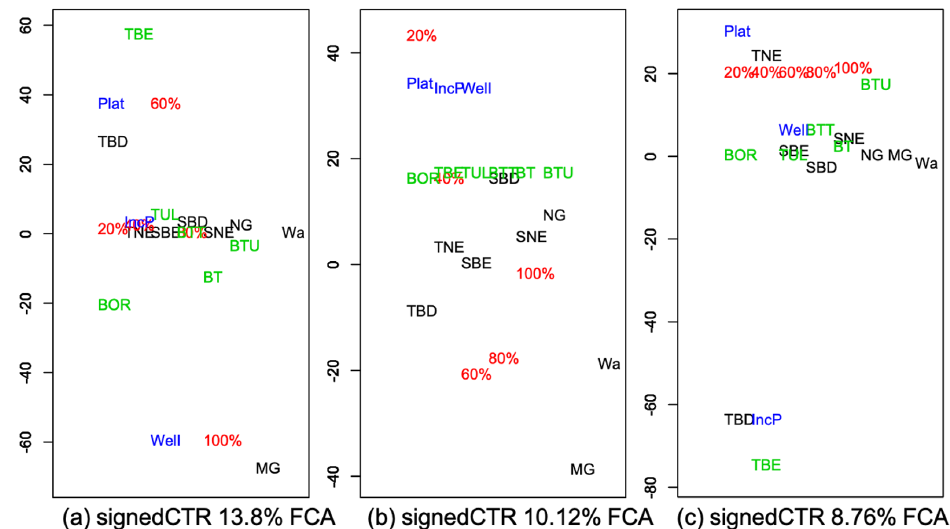
Figure 5. The three best FCA k principal tensors representing ( a ) 13.8%, ( b ) 10.12%, and ( c ) 8.76% of departure from independence. The four components of each principal tensor are all shown on the same one-dimensional plot and indicated by different colours (black = vegetation type , red = incidence quantile , green = disease , and blue = district group ), with the signed-CTR as vertical coordinate. The horizontal spread in each plot is used simply to clarify the